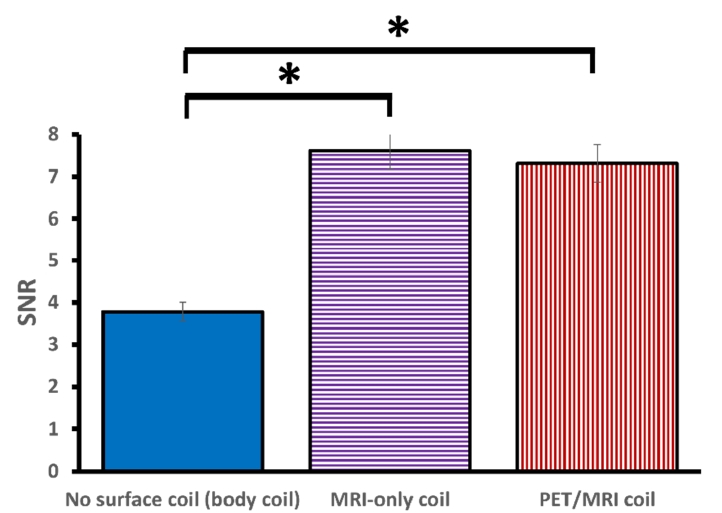
Figure 6. Mean SNR values for the three configurations. The error bars represent the standard error. PET/MRI and MRI-only showed significantly higher SNR values as compared to the configuration without a surface coil. No significant difference in SNR was observed between PET/MRI and MRI-only coils. The asterisks ("*”) indicate a significant difference in SNR ( p < 0.05). Comparing the mean SUV max values of the six tumors, the MRI-only coil values were significantly lower as compared to no surface coil (4.88 ± 0.89 vs. 6.28 ± 0.93; p = 0.04). No significant difference was present between PET/MRI and no surface coil (5.20 ± 0.43 vs.